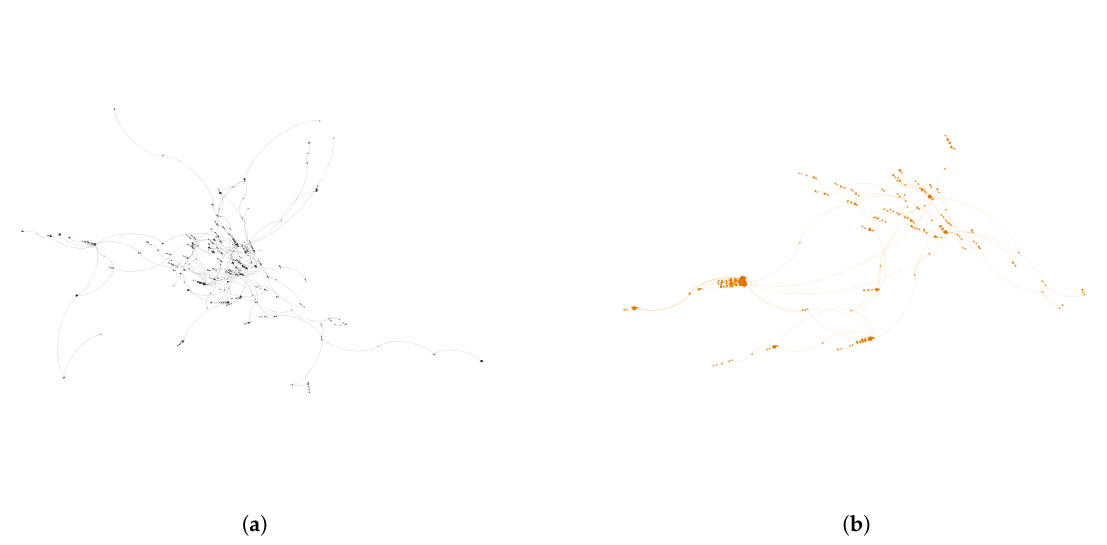
Figure 8. ( a ) SC4 is the fourth largest sub-community and is media-centred. ( b ) SC5 is the fifth largest sub-community and is centred on established public health organisations and qualified individuals. SC4 and SC5 are the fourth and fifth largest sub-communities in the Healthy Diet